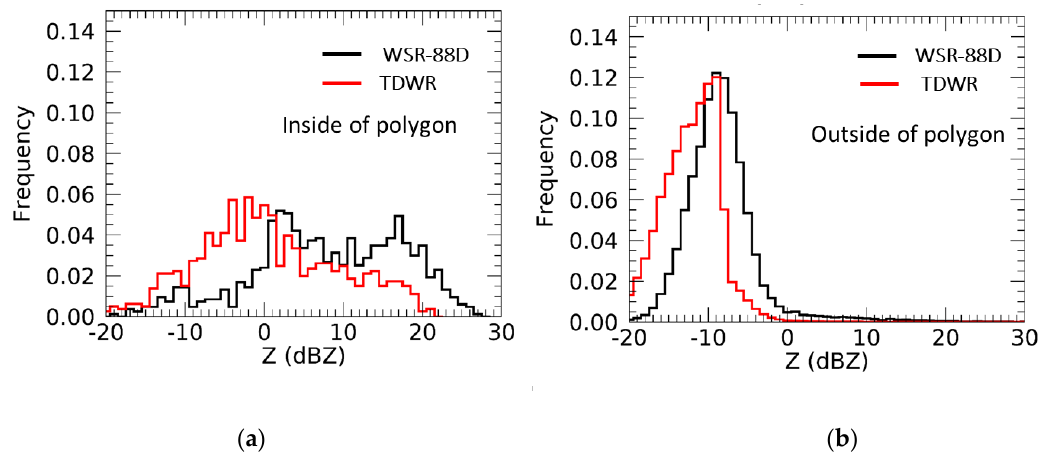
Figure 5. Histograms of reflectivity ( a ) within the enclosed areas in Figure 4; black is from the WSR-88D and red is from the TDWR. ( b ) Same as in ( a ) except the histograms are from the areas out of the enclosure. The tail of the distribution from the WSR-88D extends to 30 dBZ, whereas the one from the TDWR extends to 20 dBZ.